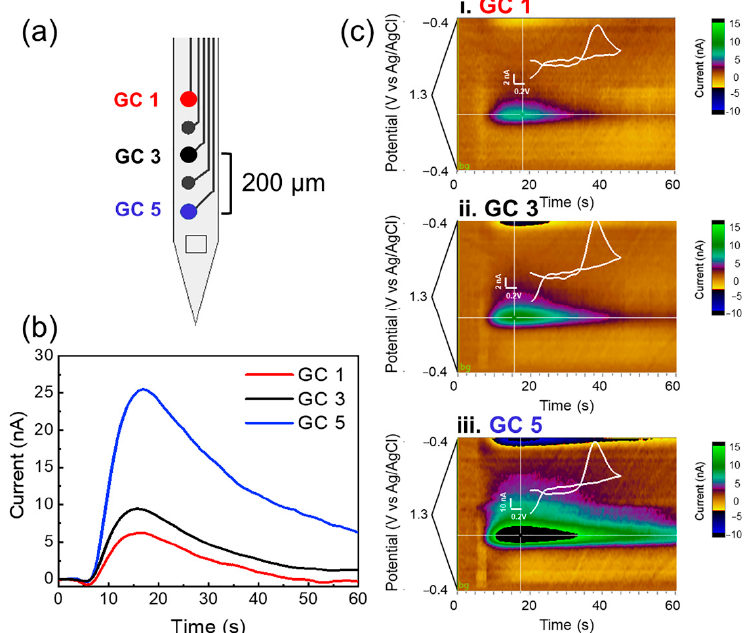
Figure 3. Multichannel detection from 3 GC channels (200 μ m interelectrode distance). ( a ) Schematic of a 5-channel GC MEA with pointed out the electrode used. ( b ) Current/time plot of DA released in the dorsal striatum, evoked by electrical stimulation of DA axons in the medial forebrain bundle (MFB), using 3 GC microelectrodes with 200 μ m interelectrode vertical distance; ( c ) corresponding color plots for evoked DA concentrations from the 3 different GC microelectrodes. These recordings are obtained after pharmacological manipulations (2 mg/kg raclopride and 20 mg/kg NOM).